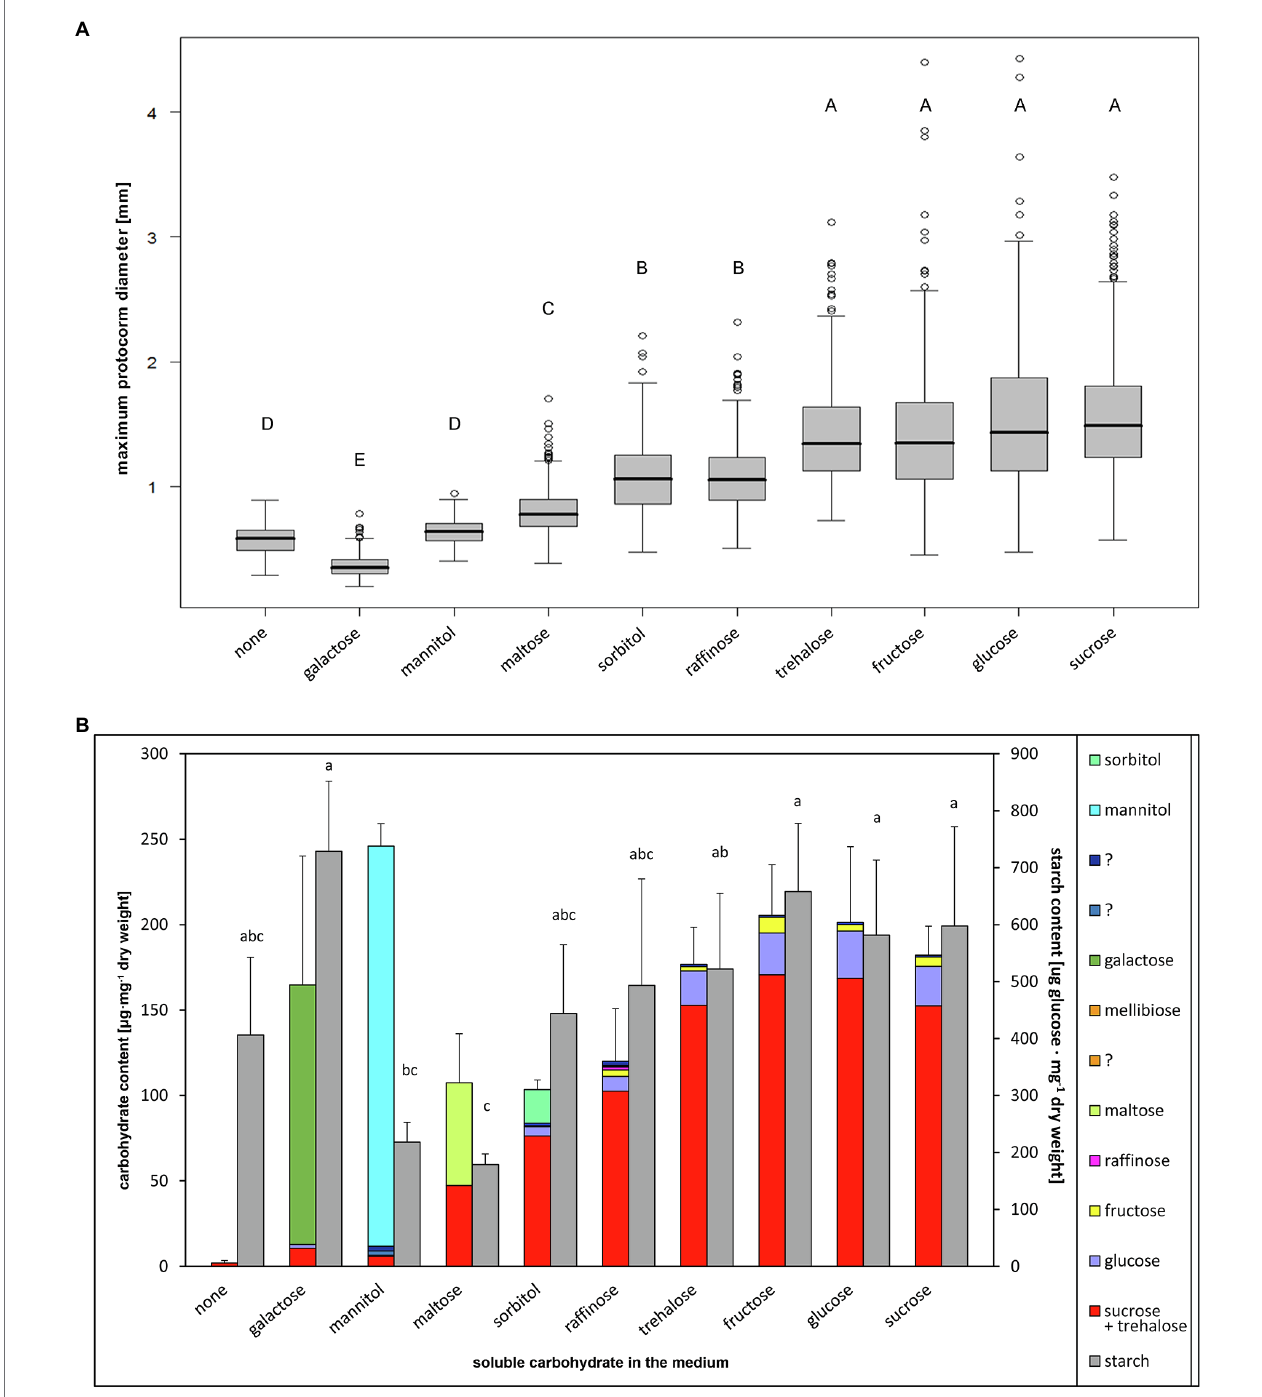
FIGURE 1 | Effect of soluble carbohydrate type in the medium on Dactylorhiza majalis protocorms. 4-month cultivation on medium SMS with 100 mM monosaccharides, 50 mM disaccharides, 33.3 mM raffinose. (A) Protocorm size, median values are given. Nested ANOVA followed by TukeyC test (log- transformed data, α = 0.05). (B) Non-structural carbohydrate contents in protocorms, mean values and SD of total soluble carbohydrate and starch contents are given. Different letters indicate significant differences according to ANOVA followed by the Tukey–Kramer test ( α = 0.05). For soluble carbohydrate statistics see Supplementary Table 1